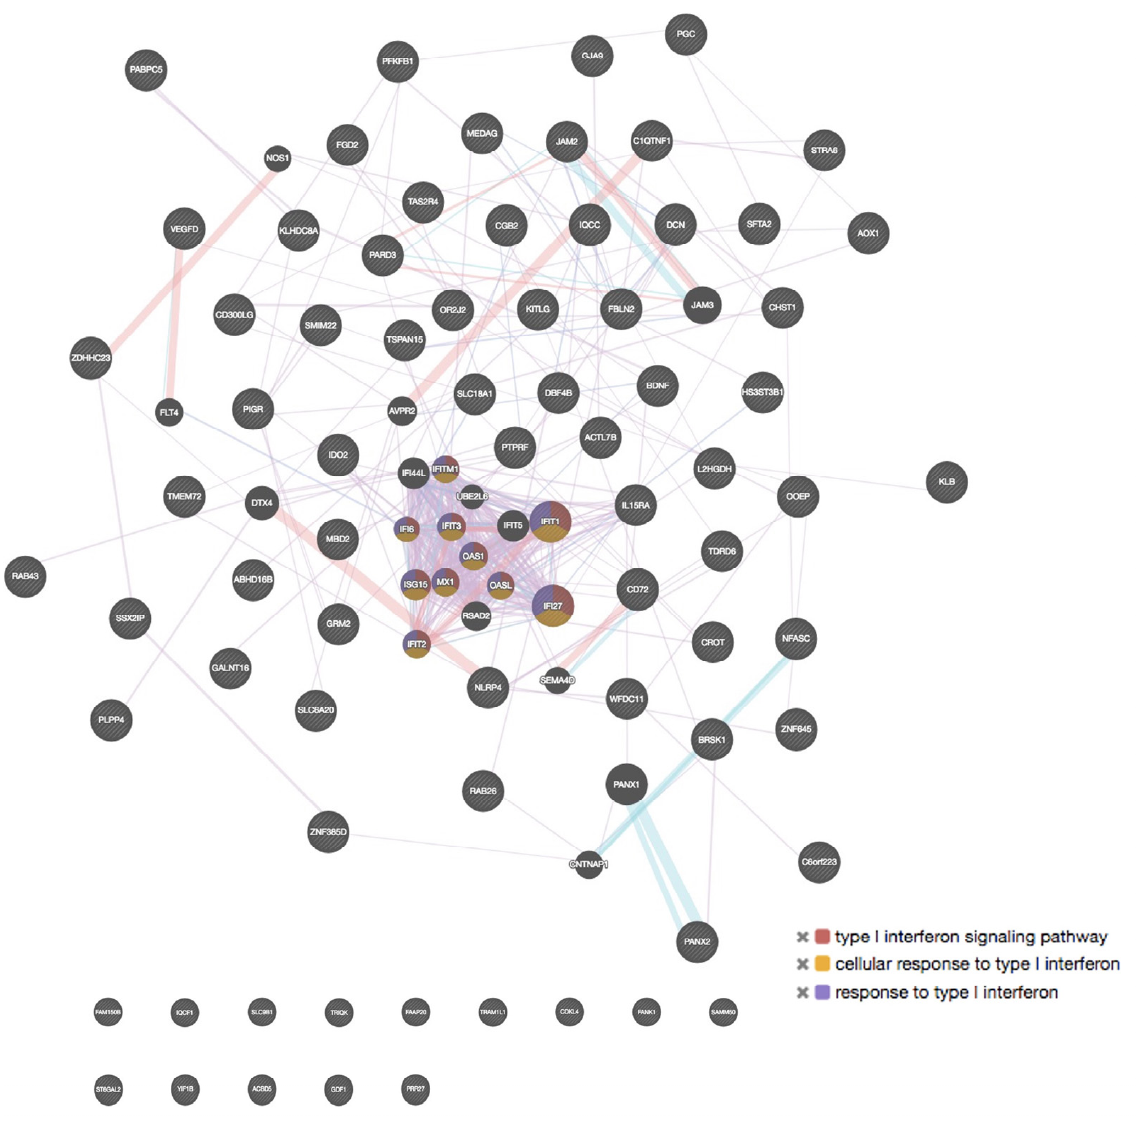
Figure 10. GeneMANIA tool interaction analysis of overexpressed genes in BMMCs exposed to per ‐ methrin.